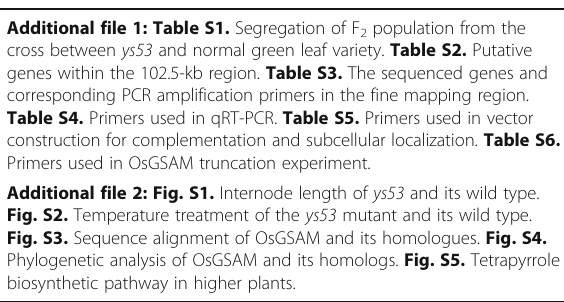
Table S4. Primers used in qRT-PCR. Table S5. Primers used in vector construction for complementation and subcellular localization. Table S6. Primers used in OsGSAM truncation experiment. Fig. S3. Sequence alignment of OsGSAM and its homologues. Fig. S4. Phylogenetic analysis of OsGSAM and its homologs. Fig. S5. Tetrapyrrole biosynthetic pathway in higher